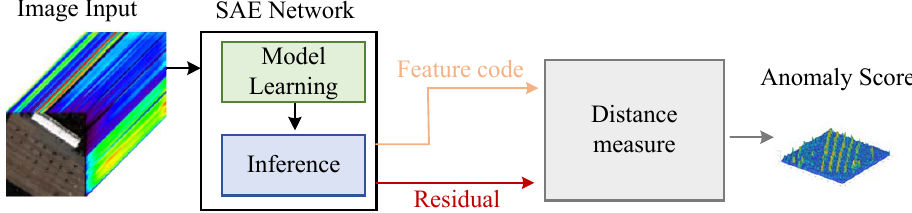
Figure 8. An stacked-auto-encoder (SAE) based HSI anomaly detector